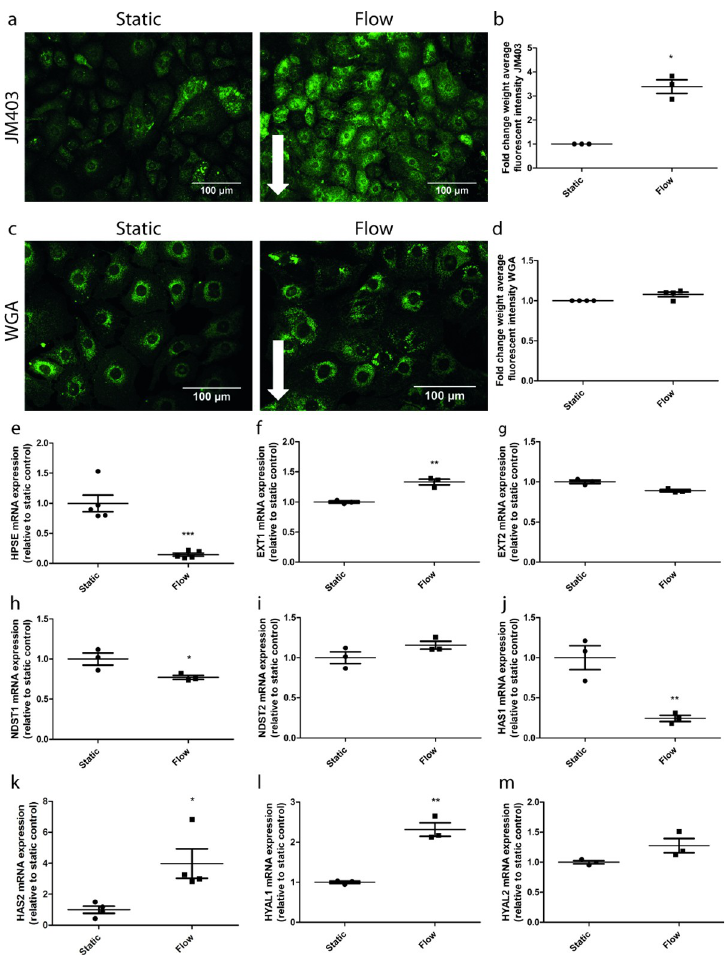
Fig 3. Laminar flow alters the composition of the endothelial glycocalyx. mGEnCs were cultured under static conditions or under a laminar flow of 5 dyn/cm2 for 7 days. Representative images for the HS staining with JM403 ( A ) or WGA ( C ) under static (left panel) or flow (right panel). Arrows indicate the direction of the flow applied. Quantification of the fluorescent intensity of the JM403 ( B ) and WGA ( D ) staining. mRNA expression levels of HPSE ( E ), EXT1 ( F ), EXT2 ( G ), NDST1 ( H ), NDST2 ( I ), HAS1 ( J ), HAS2 ( K ), HYAL1 ( L ) and HYAL2 ( M ) in mGEnCs cultured under either static conditions or flow. � p < 0.05 �� p < 0.01 ��� p <